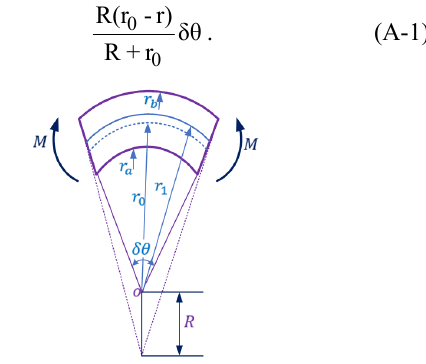
Figure A-1. Thick curved beam element, under a pure bending